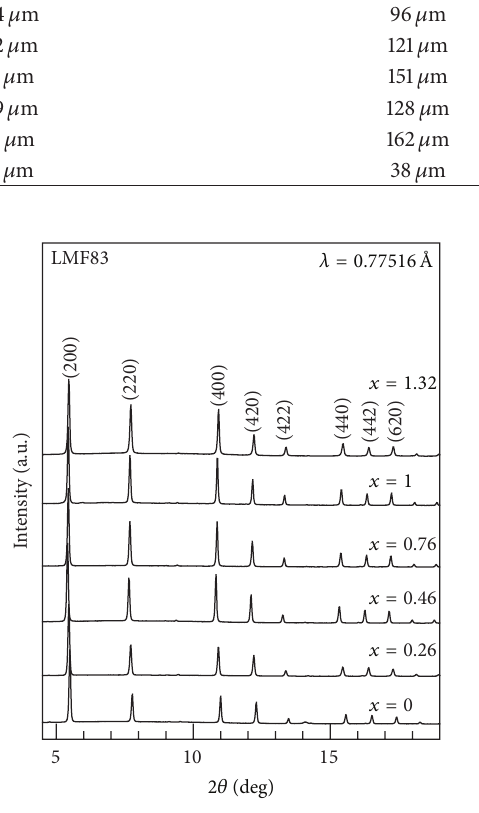
Figure 3: XRD pattern of powered LMF83 against Li concentration ( 𝑥 ). Values in parentheses represent indexes in the face-centered cubic setting (cited from